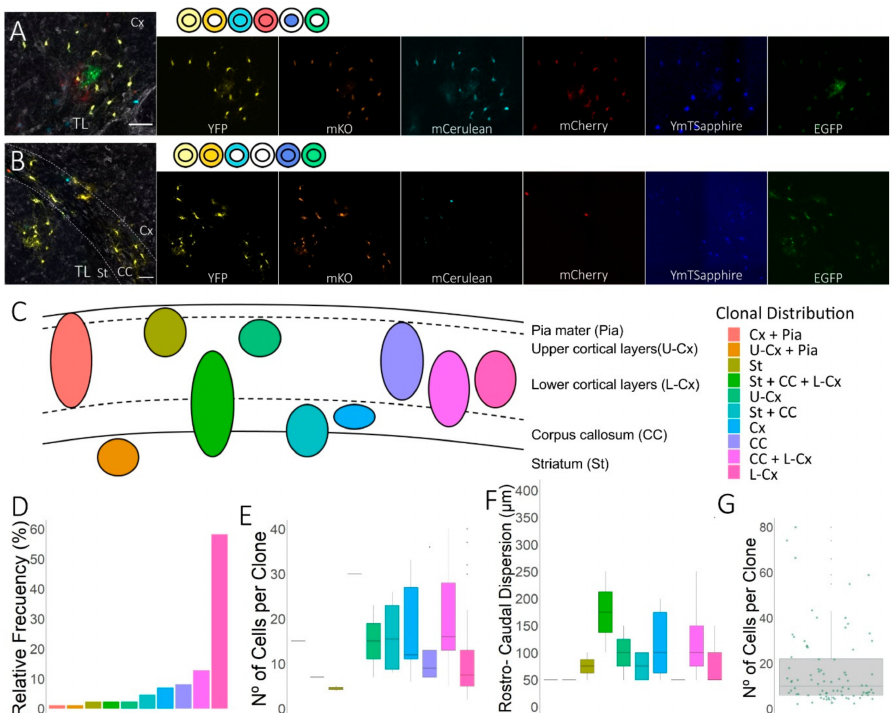
Figure 2. Clonal distribution of NG2-glia in coronal sections. ( A , B ) Detail of sibling NG2-glia close to the lesion in the cerebral cortex ( A ) and striatum and corpus callosum ( B ). A ff ected areas were identified by tomato lectin (TL) staining and clonally-related cells showed equivalent color combinations, detailed at the side of the merged images. ( C ) Scheme showing the diverse patterns of clonal NG2-glia dispersion. Dorsal E14 progenitors from the lateral ventricle produced di ff erent patterns of clonal NG2-glia progeny in the EAE-lesioned brain, with a heterogeneous clonal dispersion within the striatum (St), corpus callosum (CC), the upper- (U-Cx] and lower-cortical layers (L-Cx]), and the pia mater (Pia). ( D ) The relative frequency of the di ff erent clonal distributions estimates the frequency of each clone pattern in the EAE mice, indicating that NG2-glia clones derived from pallial progenitors expanded preferentially within the lower cortical layers. ( E ) The number of cells per clone varied depending on the cell fates of the clone. The largest clones were those distributed within the CC. ( F ) The largest clones exhibited a more extended rostro-caudal axis dispersion with sibling cells occupying a maximum average dispersion of 330 µ m. ( G ) The clones varied in size from 3 to 80 cells, with an average of 17 cells per clone. Scale bars, 50 µ m ( A , B